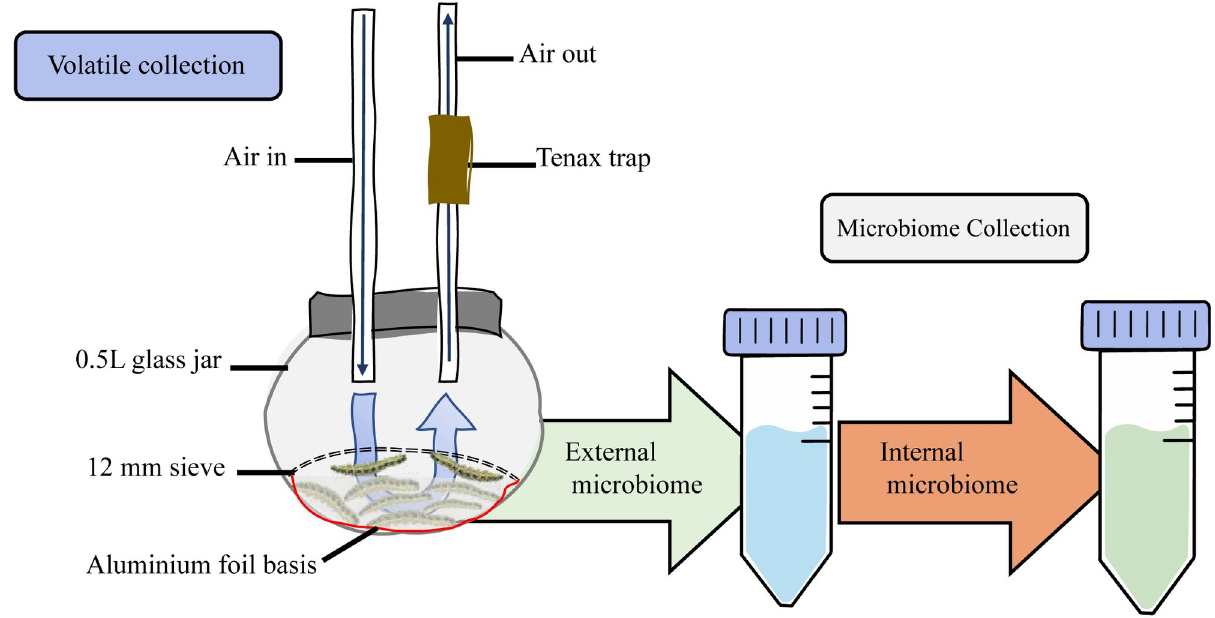
Fig 1. Experimental setup for the caterpillar odour and microbiome collection. Groups of eight C . glomerata parasitised or unparasitised caterpillars were placed in a glass jar with a restriction device. A dynamic air current was led through the setup and VOCs were trapped in a Tenax trap. After headspace (odour) trapping, the same caterpillars were subjected to the collection of their external and internal microbiome in PBS-Tween80 solutions.